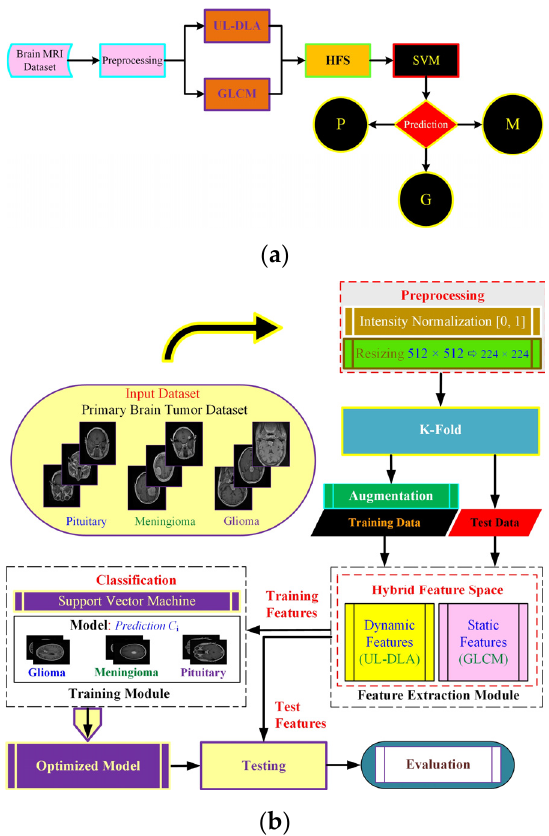
Figure 1. The proposed Ultra-Light Brain Tumor Detection (UL-BTD) system is based on UL-DLA and textural features. Diagram ( a ) shows the entire workflow of the proposed technique { P : Pituitary, G : Glioma, and M : Meningioma}, whereas diagram ( b ) shows the phases of the proposed technique in detail.